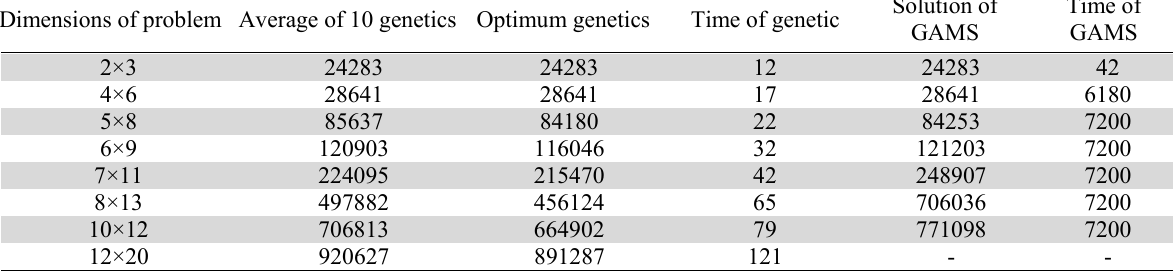
Comparing the obtained results from GA and GAMS